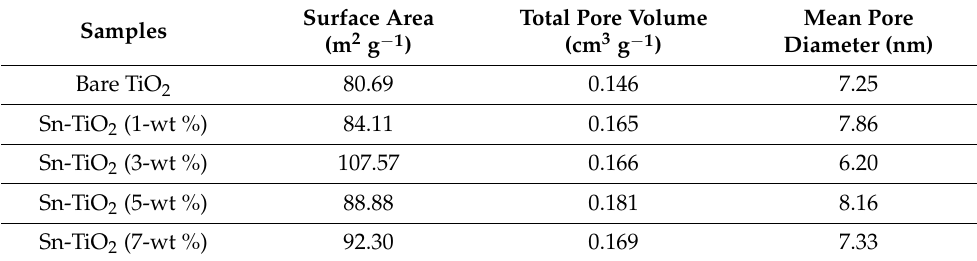
Table 1. Surface area, pore volume, and pore diameters of bare-TiO 2 and Sn-TiO 2 thin